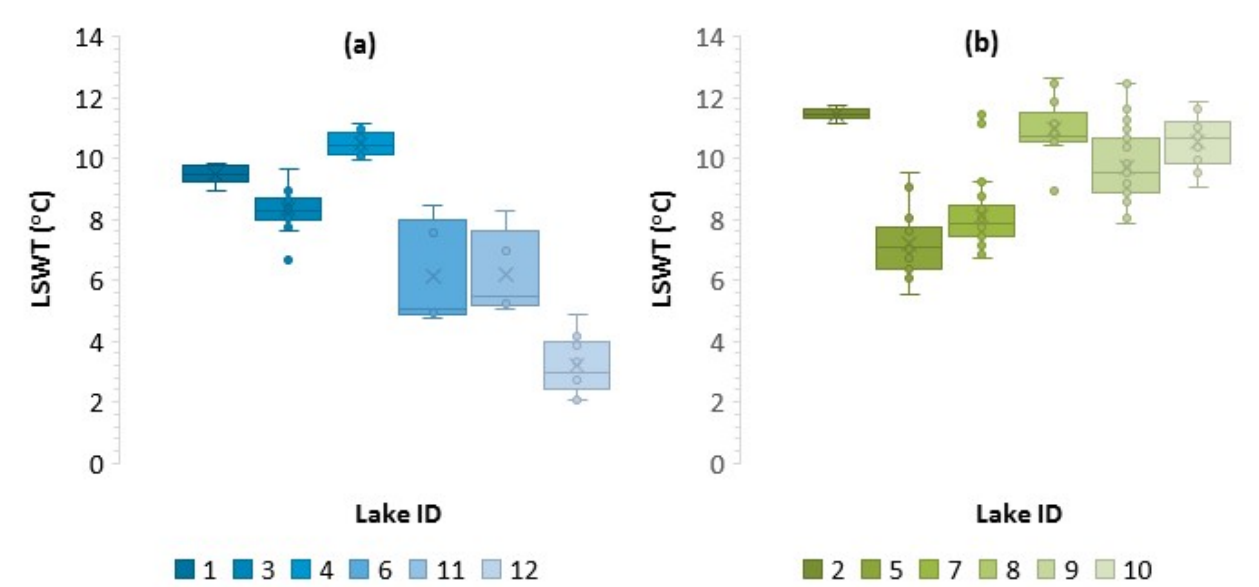
Figure 6. Box and whisker plots of lake surface water temperatures extracted from AST08 temperature product pixels over Arctic Sweden on 8 August 2014 at 10:46 a.m. for ( a ) ice-contact proglacial lakes and ( b ) non ice-contact proglacial lakes. Whiskers extend to points within 1.5 times the interquartile range (IQR) from the upper and lower quartile. Points 1.5 times the IQR from the upper and lower quartile are plotted as outliers. With x = mean and central line = median. Lake ID = AST08 ID .